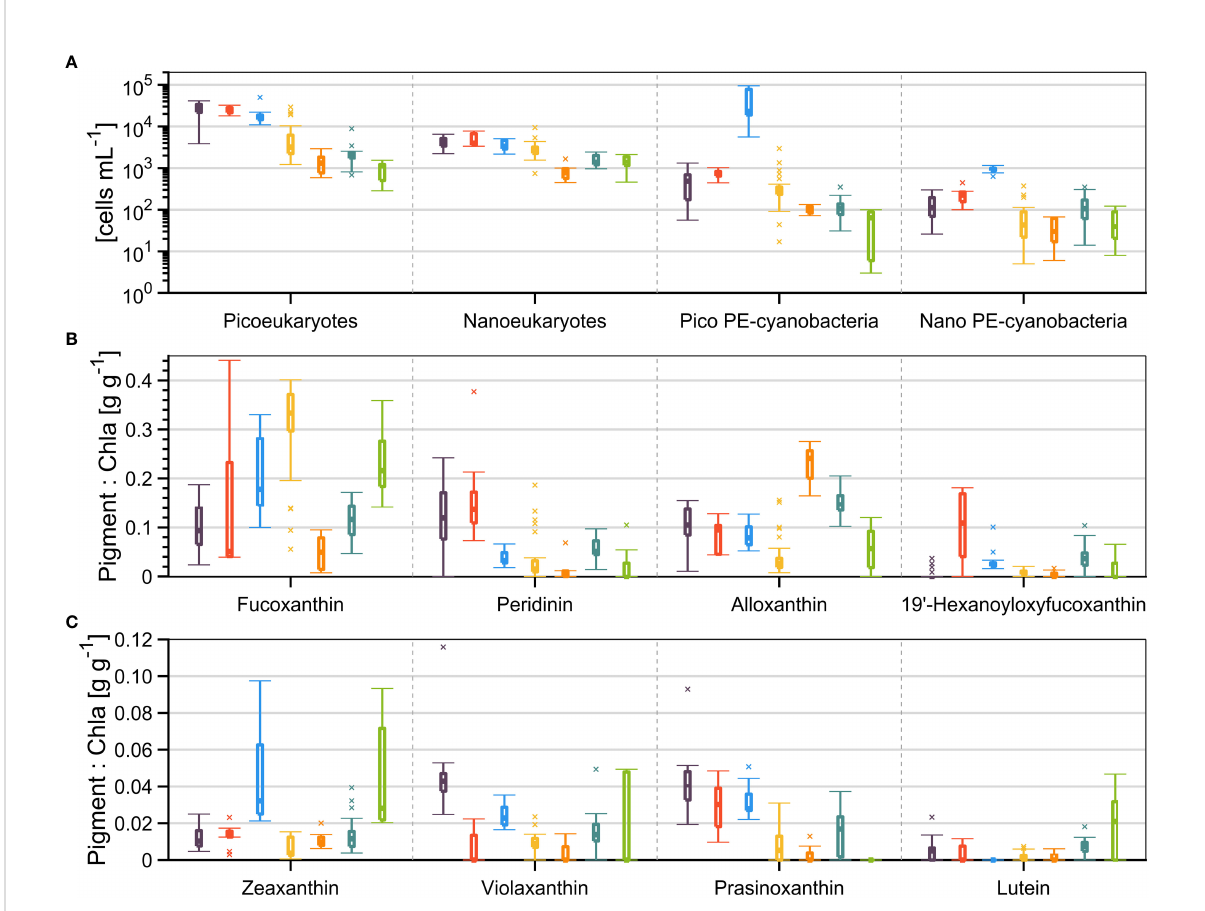
FIGURE 3 Variability (median, 25th and 75th percentiles, minimum, maximum and outliers) of (A) four classes of phytoplankton cell abundances (B, C) and eight accessory pigments to Chla ratios concentrations. The autotrophic cells concentration is separated by eukaryotes and phycoerythrin- containing (PE-) cyanobacteria, and by pico- (<2 m m) and nano-size (>2 and <20 m m) classes. The color code, associated to each cluster group, is the same as in Figure